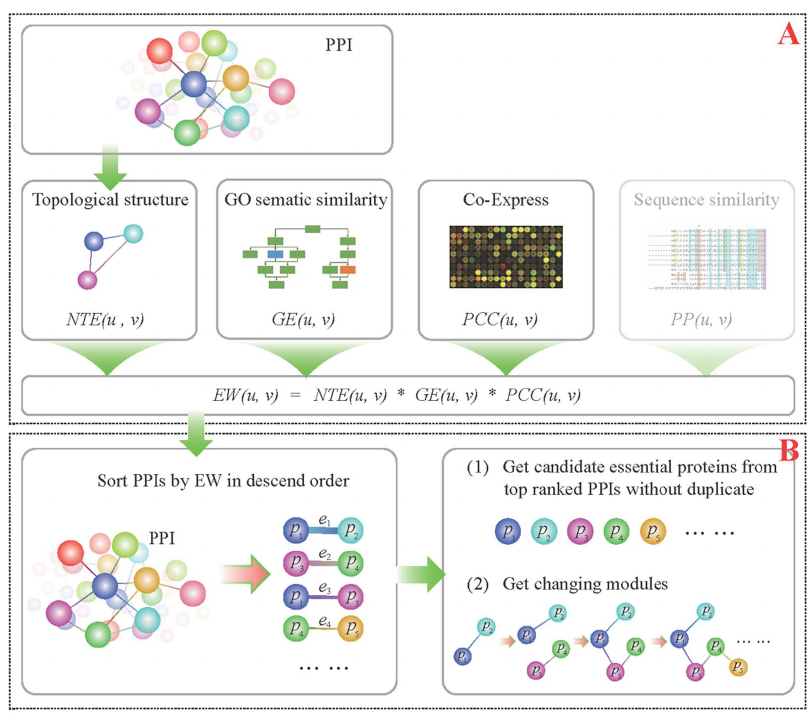
Figure 1. The whole workflow of EW method. ( A ) Edge Weight Computation; ( B ) Essential Protein Identification based on Edge Weights.